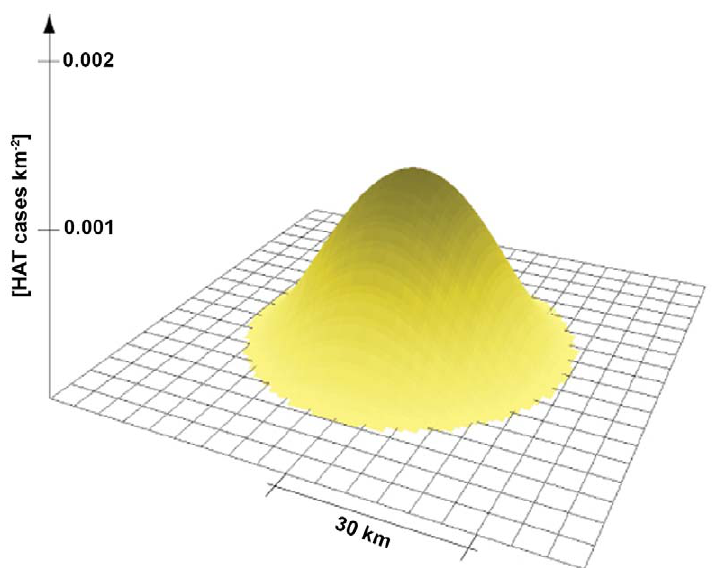
Figure 1. Three-dimensional rendering of the disease intensity surface for one case of HAT, as derived from spatial smoothing (Kernel function k ( ? ): quadratic; bandwidth t : 30 km; output resolution: 1 km).